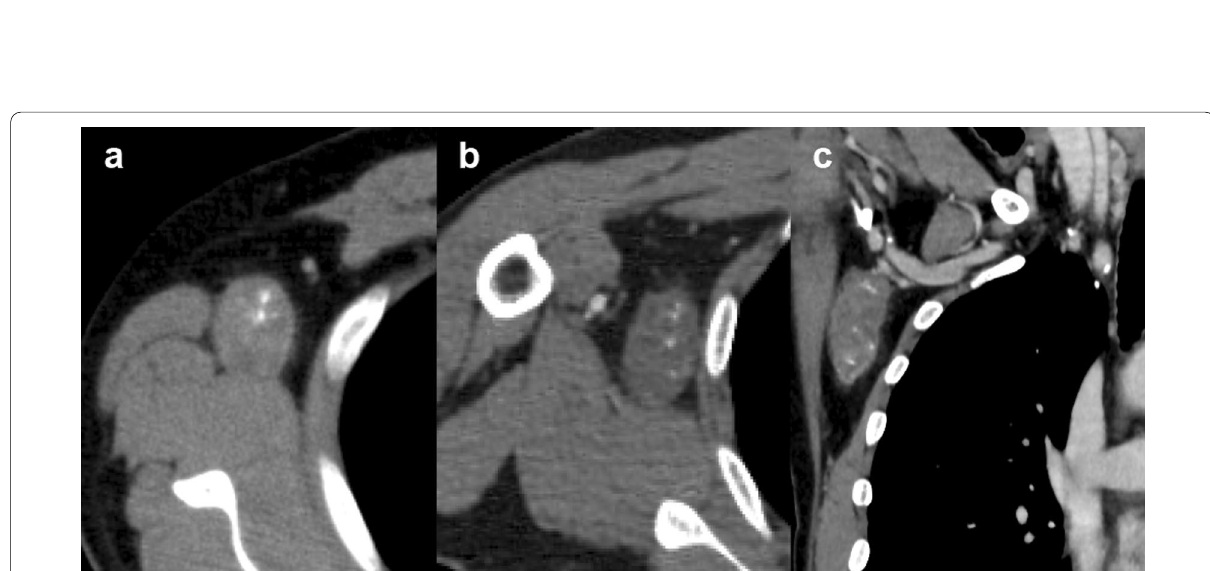
Fig. 3 Computed tomography (CT) findings of the axillary tumor. a CT showed a mass with a high absorption area. b On contrast-enhanced CT, the tumor showed poor contrast with neither chest muscle nor chest wall invasion. c In the frontal view, there was no obvious invasion of the subclavian vein. The subclavian artery was intact, but the dorsal thoracic artery could not be